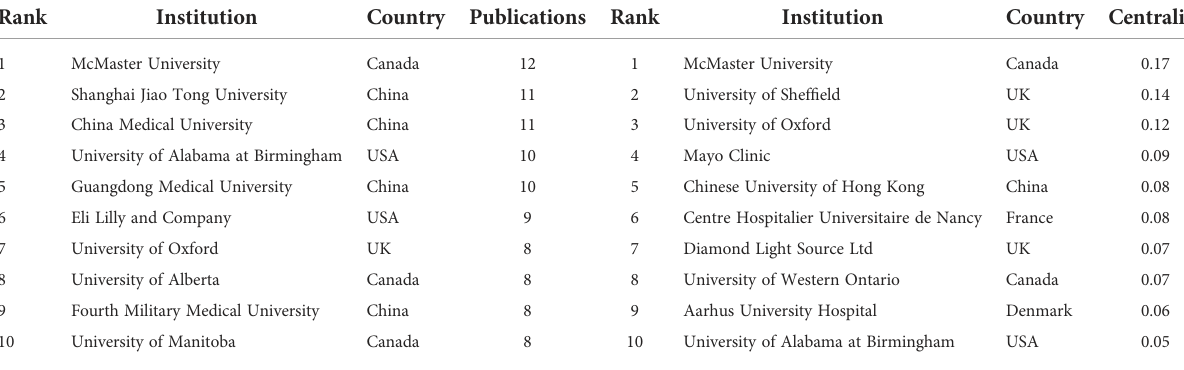
TABLE 3 Top 10 institutions in terms of publication volume and centrality. Rank